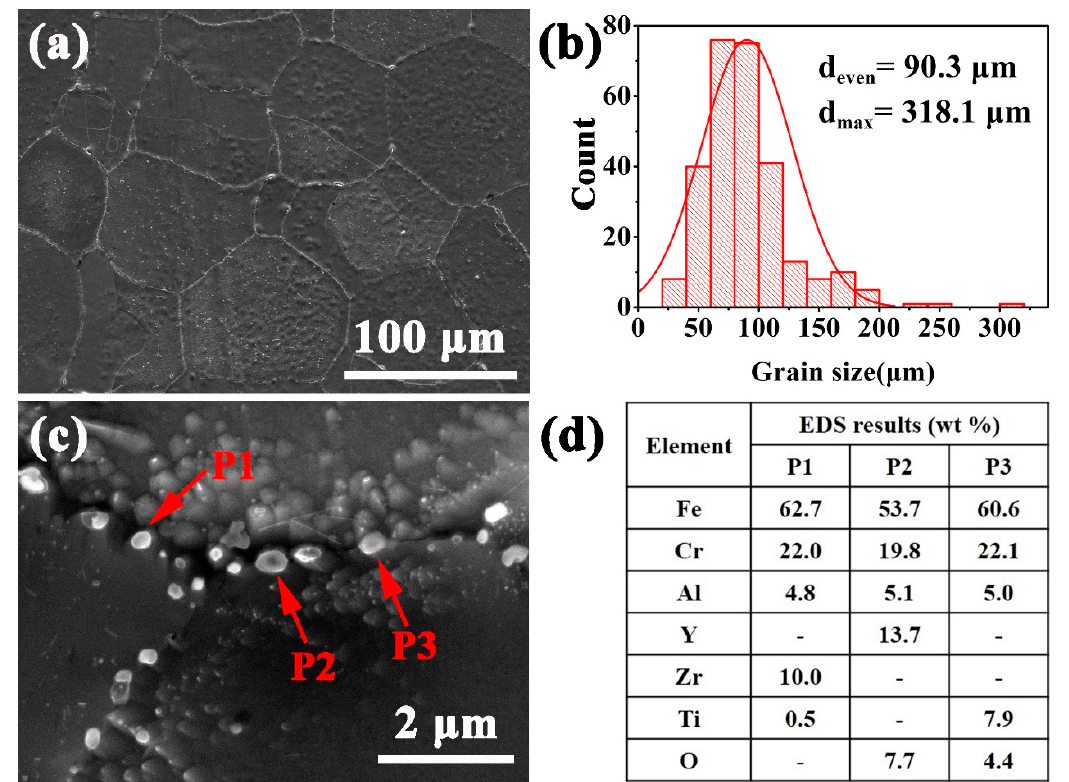
Figure 2. The XRD patterns of the as-HIPed alloys A and B.